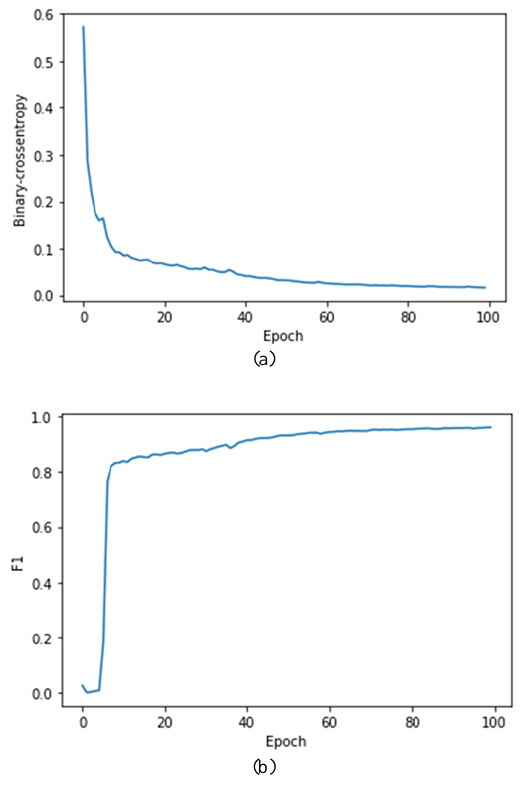
Fig. 5 (a) BCE vs epoch, (b) Training F1 vs epoch using BCE